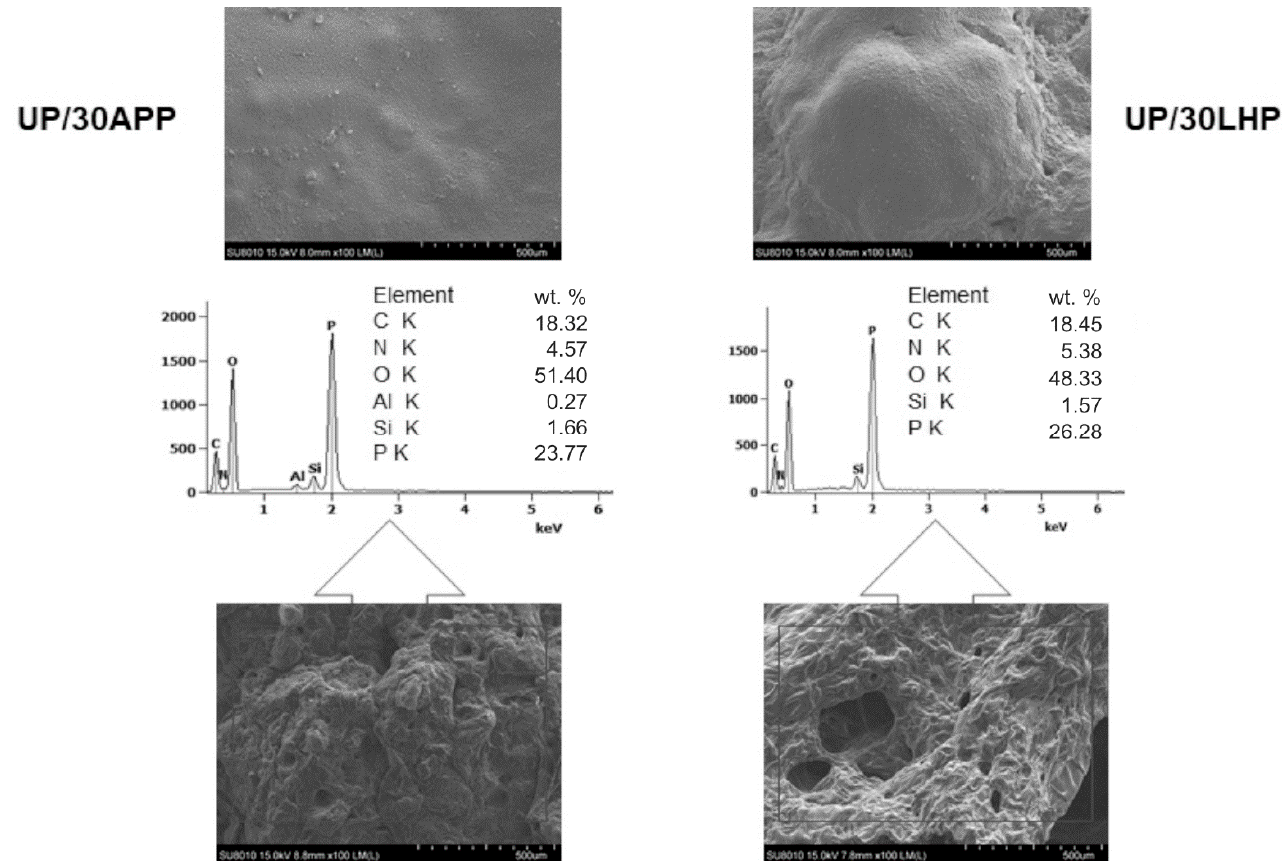
Figure 9. SEM images of UP/30APP and UP/30LHP after CC tests and EDS results (outer and inner part of char).